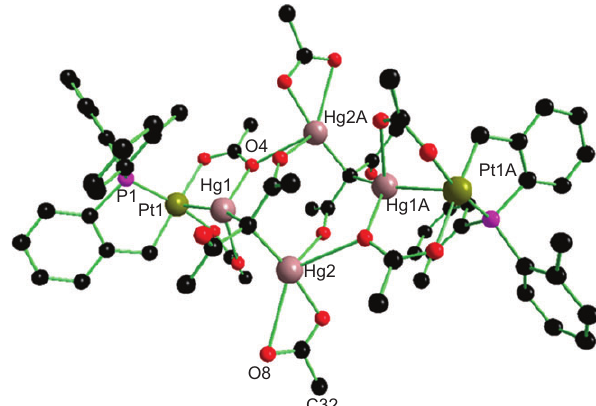
Figure 6 Molecular structure of [Pt { CH O CCH ) Hg( μ -acac)Hg(O 2 3 2